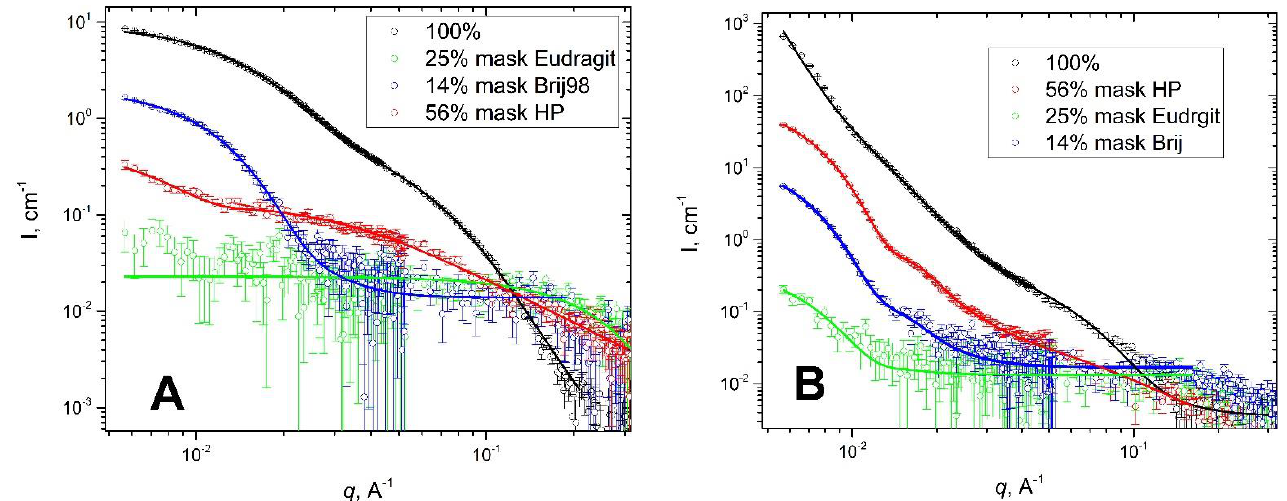
Figure 5. SANS contrast variation data for ( A ) pH = 5; and ( B ) pH = 3; Solid lines are fits.